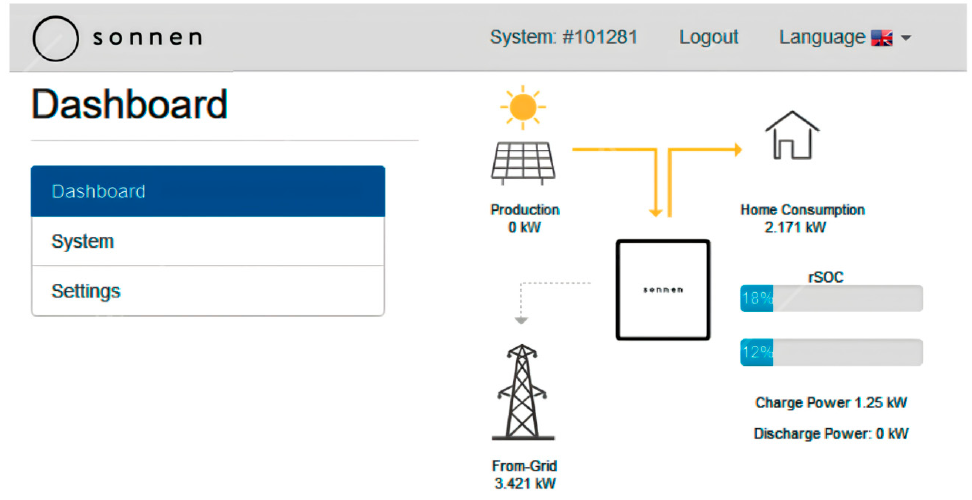
Figure 15. Sonnen